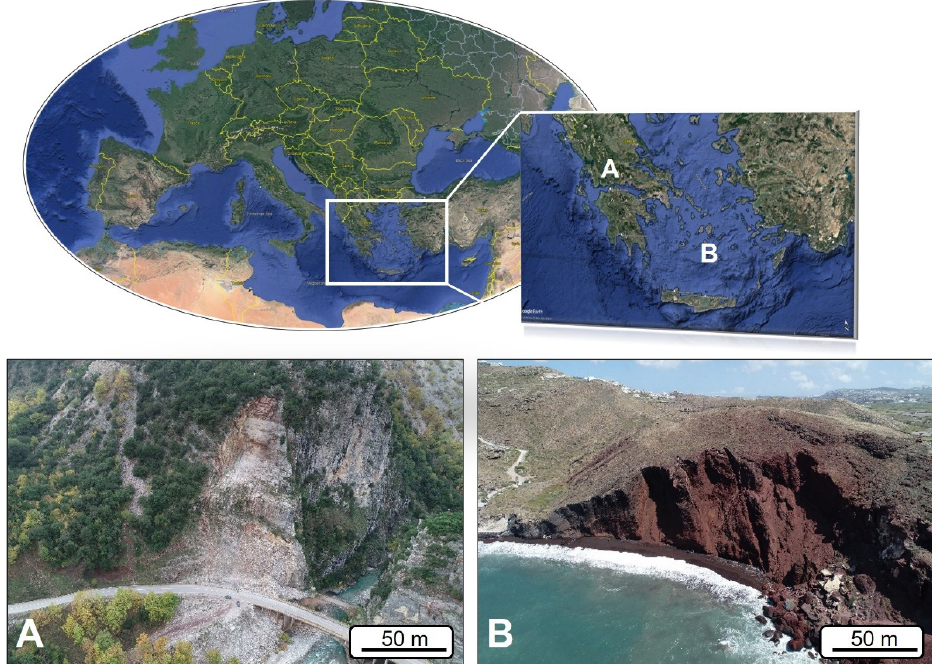
Figure 3. Overview of the landslide sites examined in the current comparative study for automatic segmentation via multi-dimensional UAV-derived digital models. ( A ): Proussos landslide and ( B ): the active Red Beach cliffs.